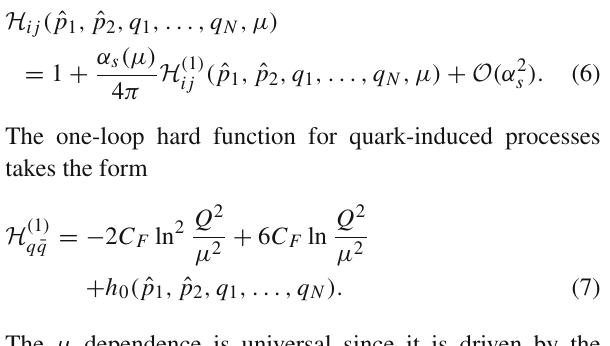
Fig. 2 Schematic representation of the beam functions that encode the collinear emissions